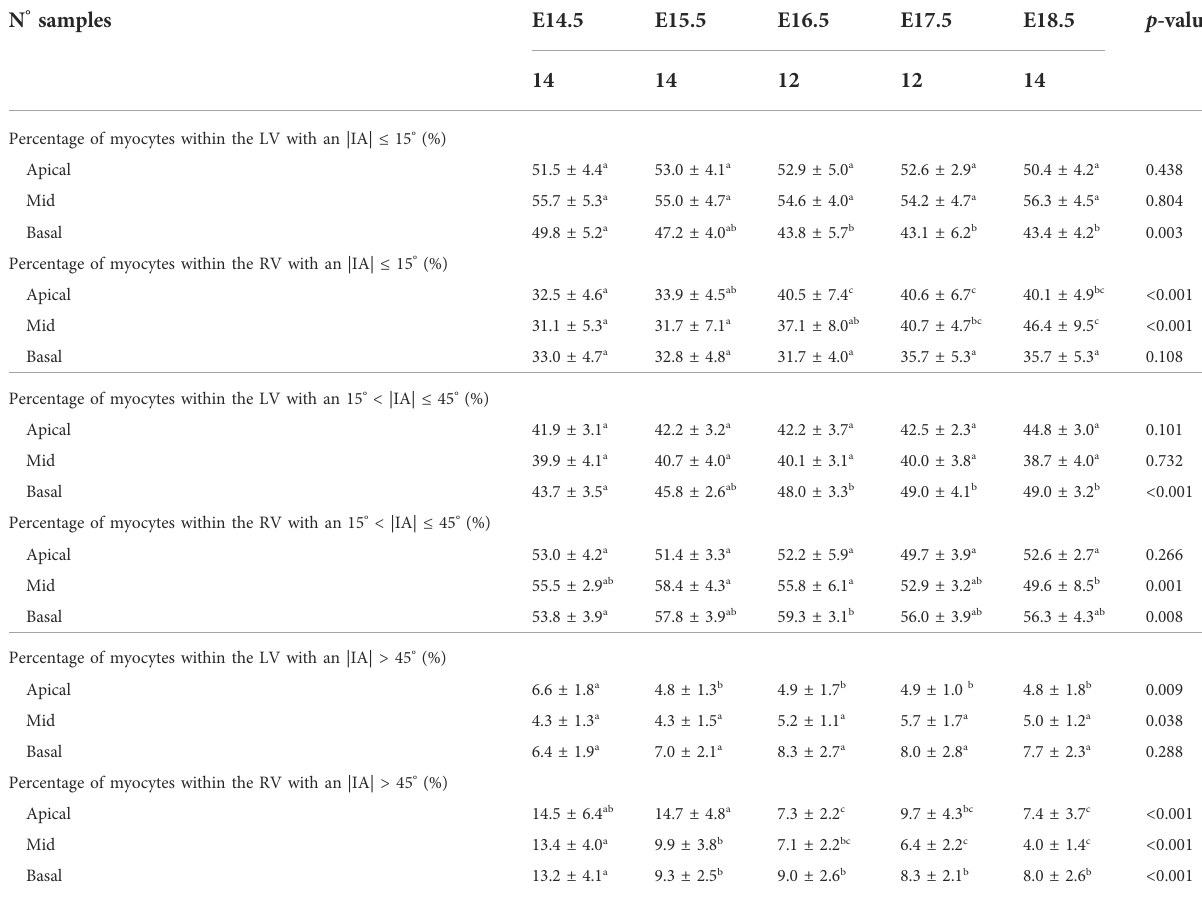
TABLE4Percentageofmyocytesarrangedparalleltotheepicardiallayer(|IA| < 15 ° ),withanIAof15 ° < |IA| < 45 ° andwithan|IA| > 45 ° withintheleft(LV) and right ventricle (RV), quanti fi ed at apical, mid and basal levels, expressed as mean ± standard deviation. N °